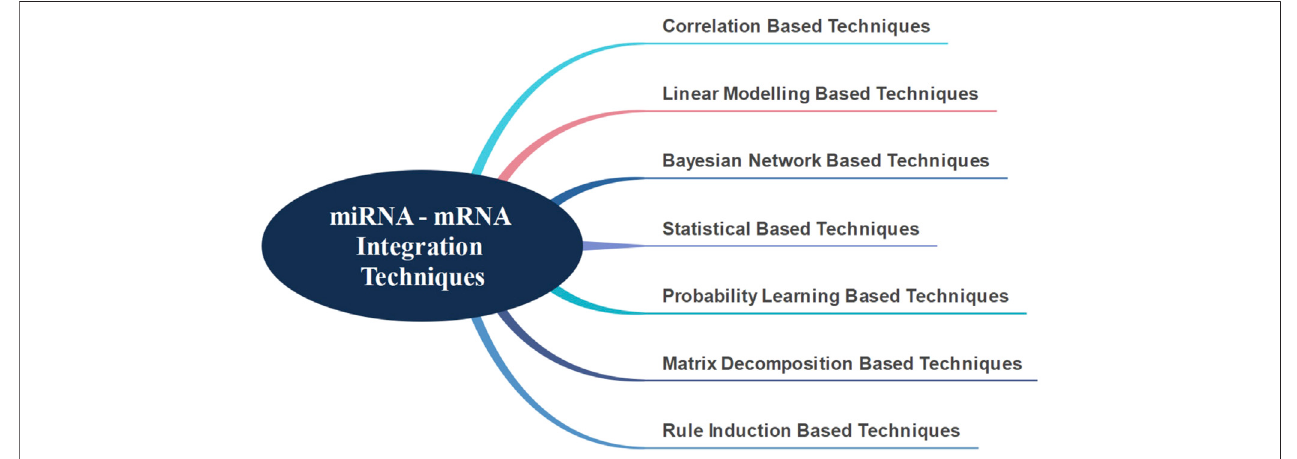
FIGURE 1 | miRNA - mRNA integration